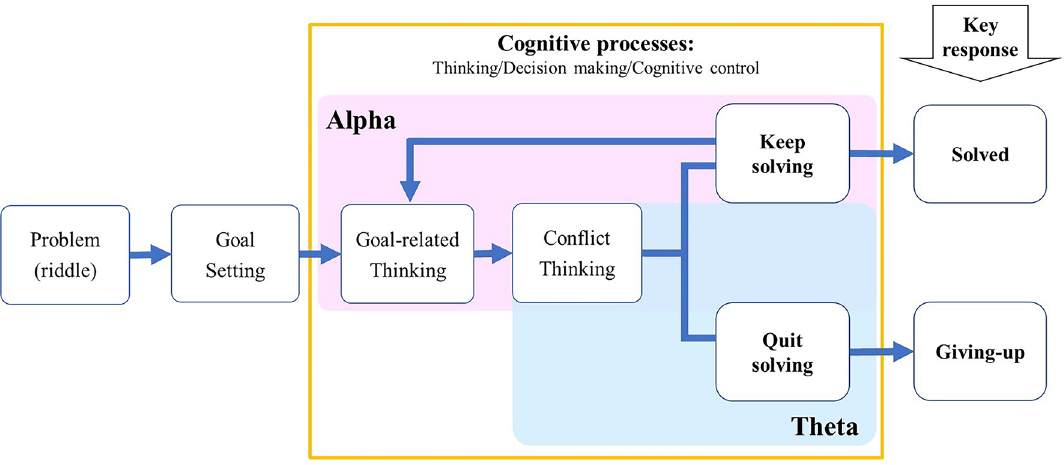
Figure 6. Hypothesised model for cognitive processes of problem-solving and